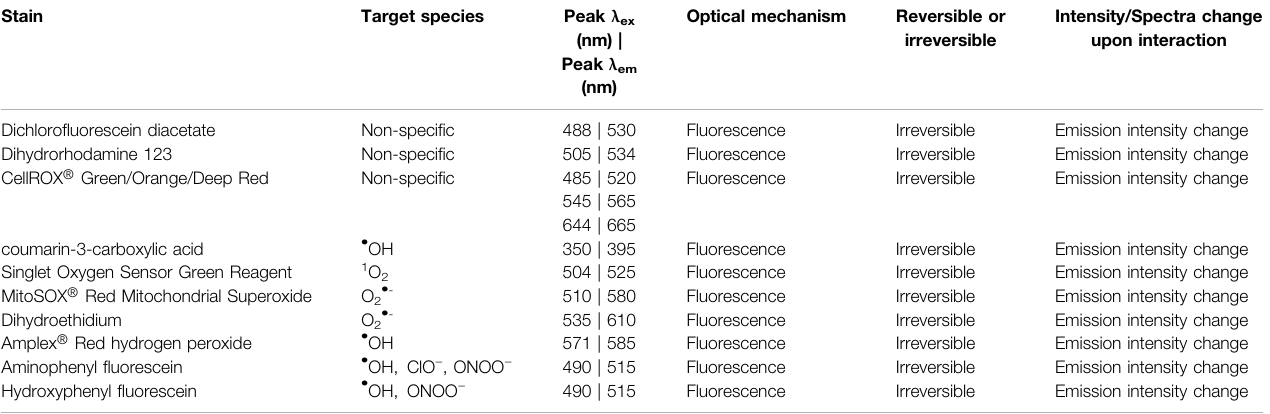
TABLE 2 | Common commercially available fl uorescence for ROS detections in biological systems.